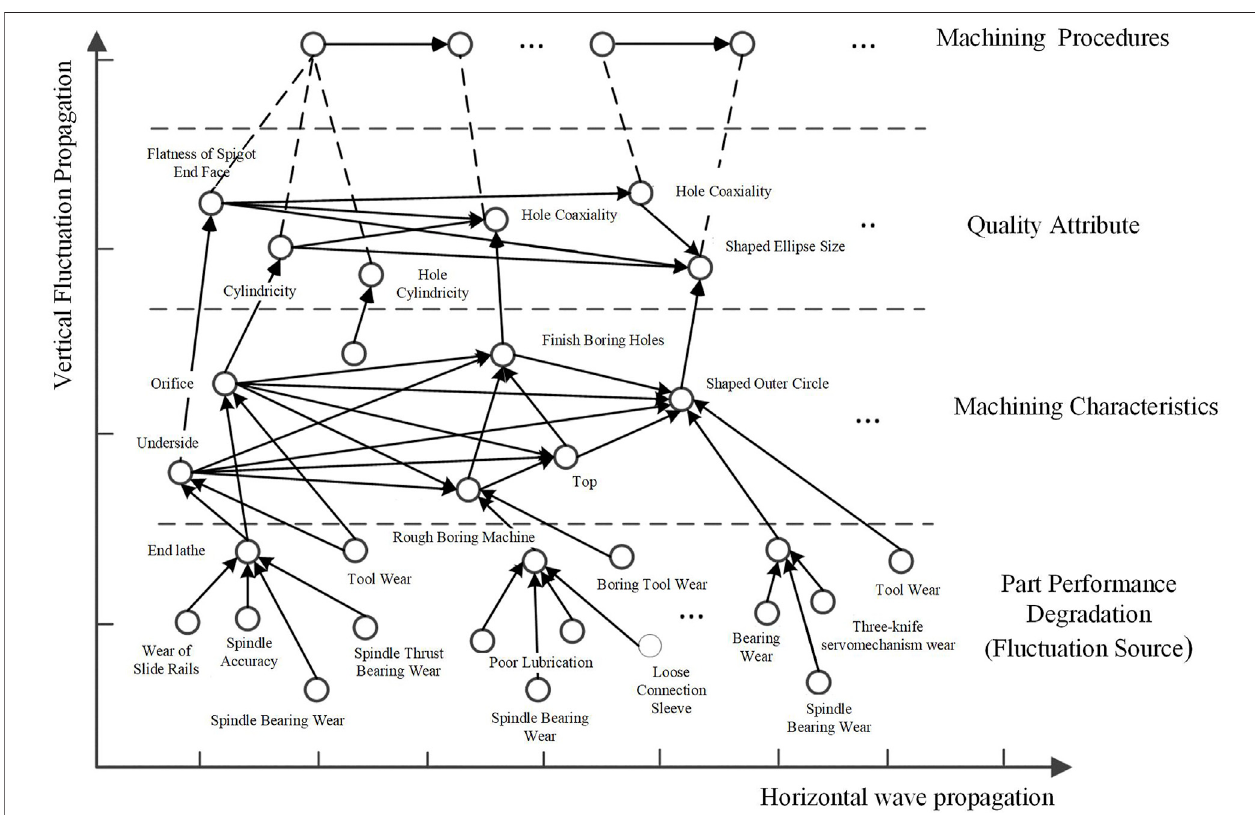
FIGURE 6 | Fluctuation propagation effect of MSC performance